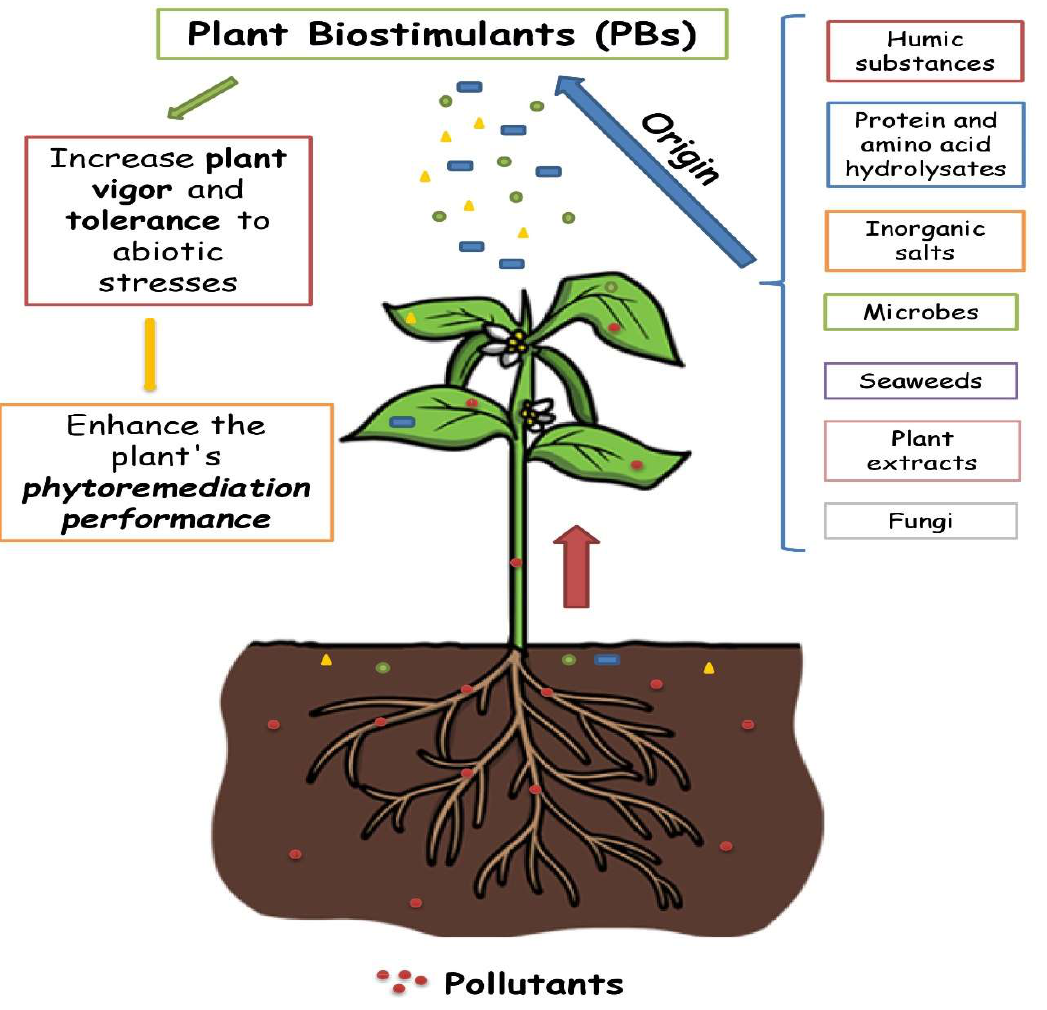
Figure 1. Beneficial effects of different origin PBs on plant response to stress and phytoremediation activity.